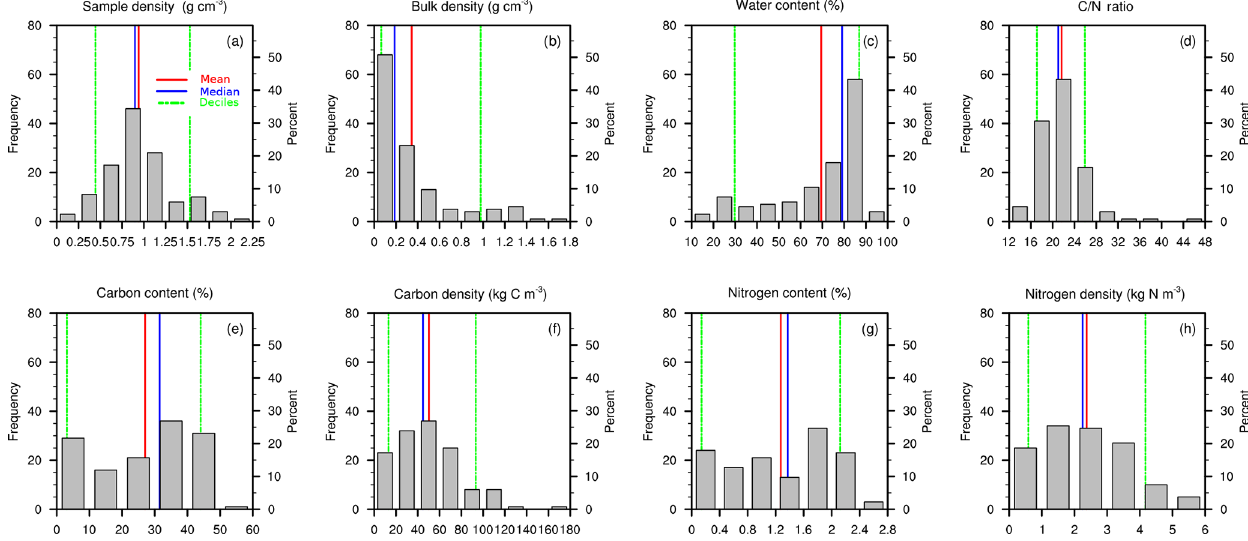
(gcm − 3 ), (c) soil bulk